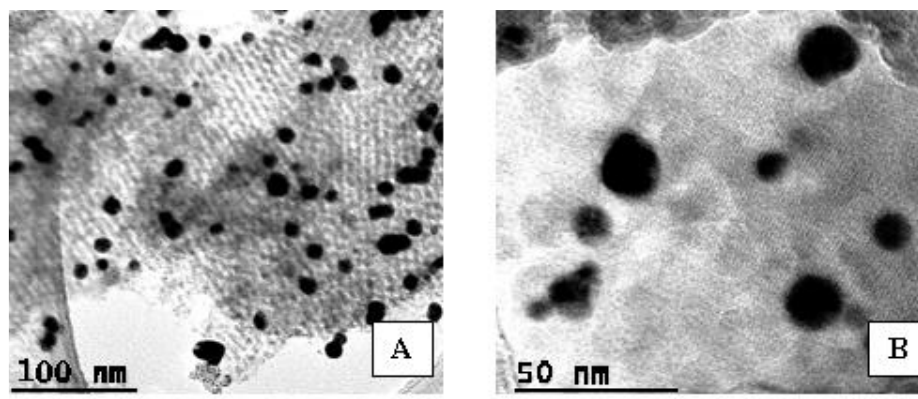
Figure 2. TEM images of KTA ( A ) and YTA ( B ) samples. According to IUPAC classification, N 2 adsorption–desorption isotherms of Ti-Au photocatalysts (Figure 3) exhibit type IV isotherm with H1 hysteresis loop for materials based on KIT-6 and H3 for the ones based on MCM-48. Analogous N 2 adsorption–desorption isotherms with hysteresis loops of both supported catalysts and their corresponding mesoporous supports imply that shape and pore dimension were not altered by titanium and gold immobilization.